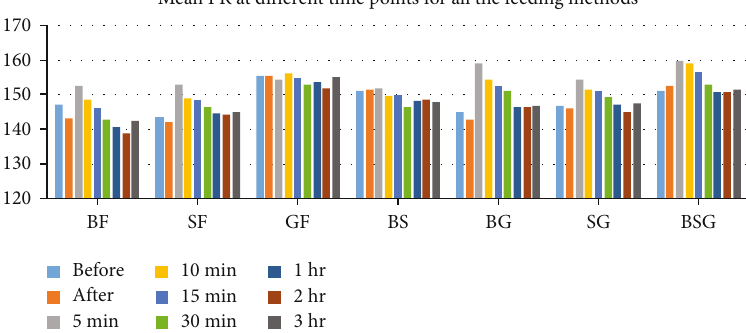
Figure 2: Mean PR at di ff erent time points for all the feeding